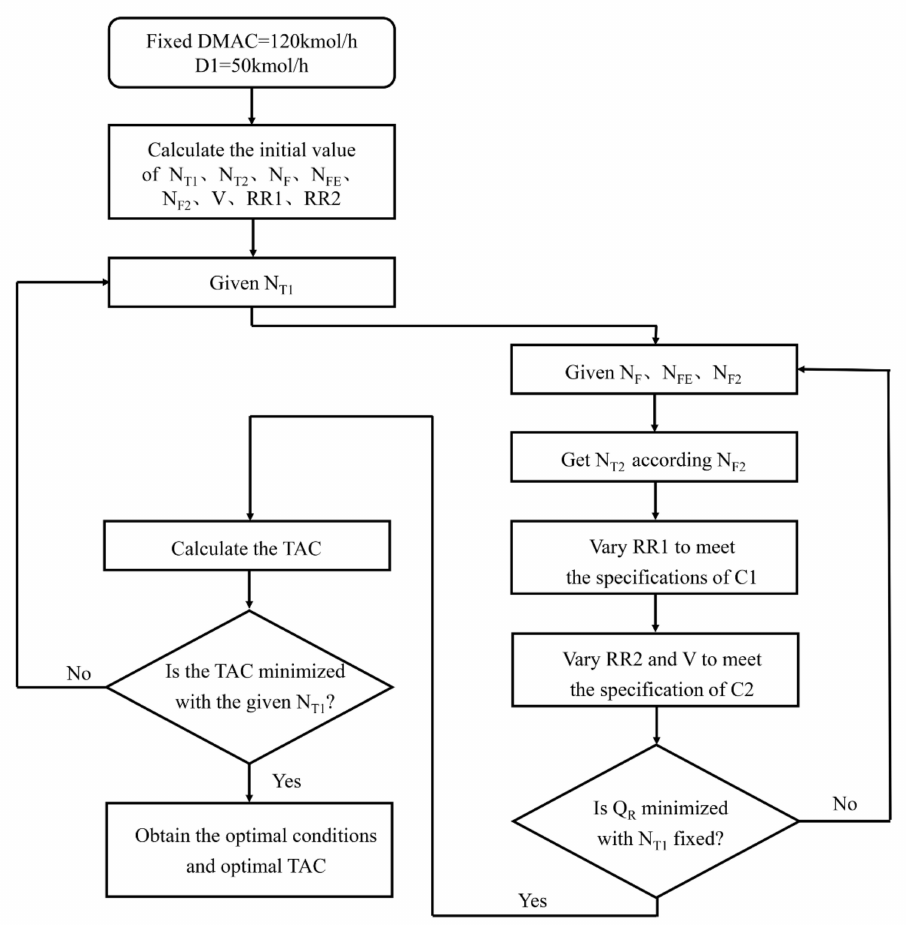
Figure 4. Sequential iterative optimization procedure for